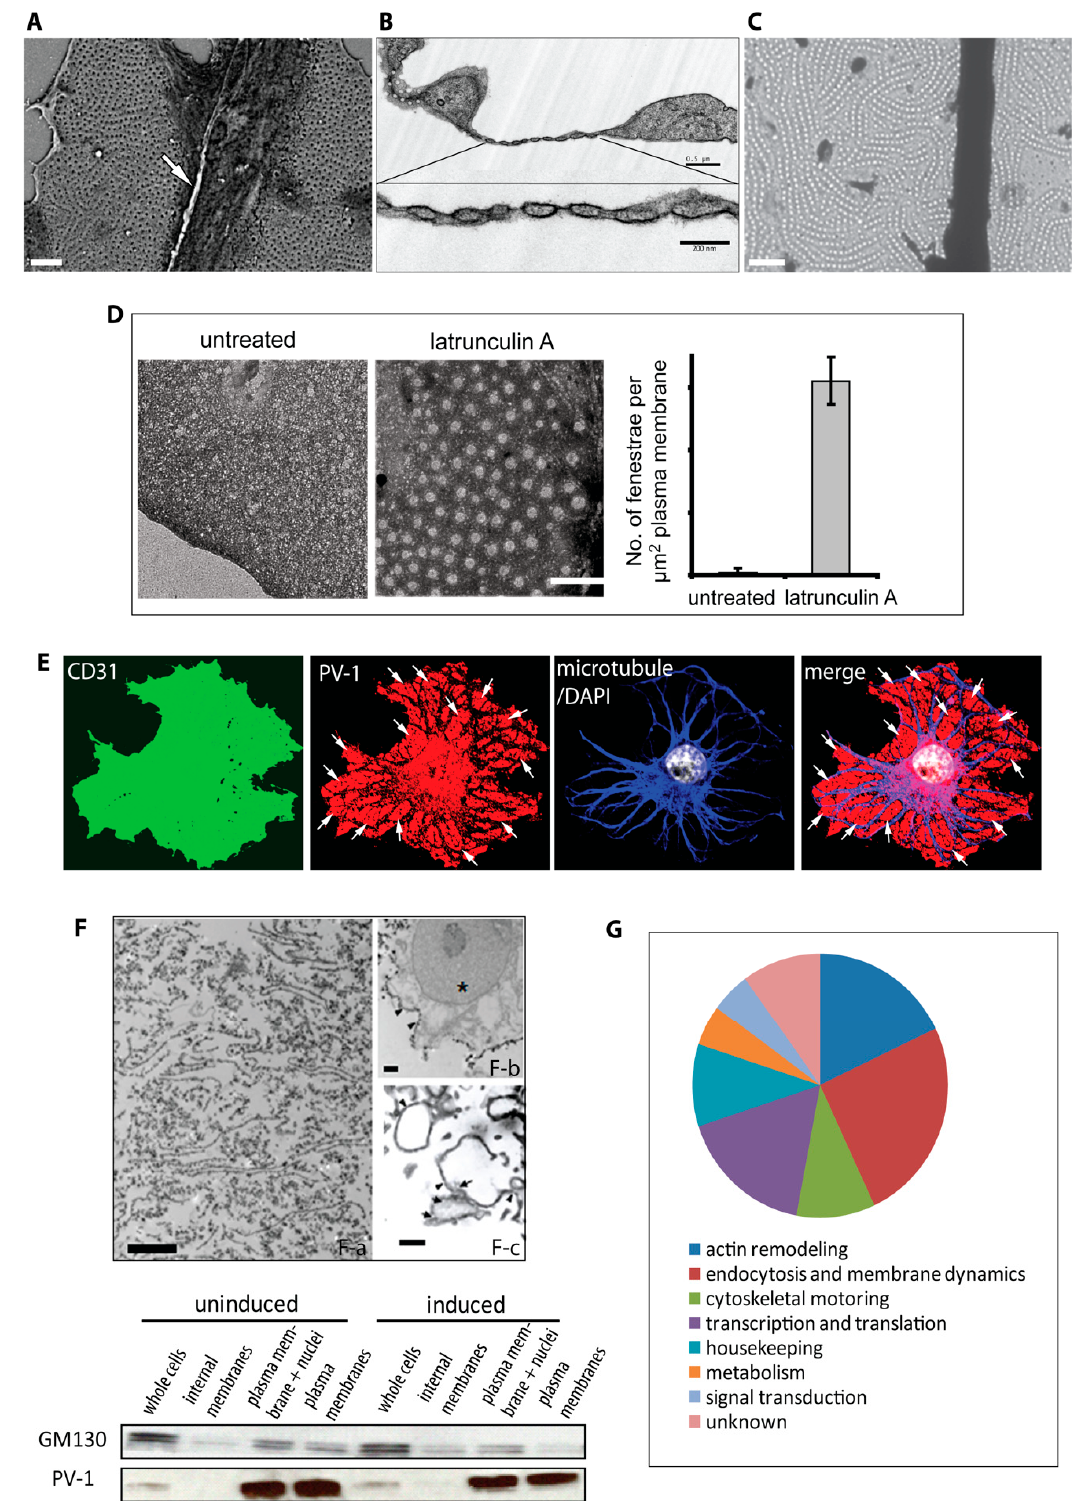
Figure 1. Fenestra morphological and proteomic characterisation. The pores are present in the highly attenuated cell periphery in clusters devoid of most organelles and cytoskeleton, termed sieve plates ( A ) SEM image (arrow, microtubule; scale bar, 1 µm). Fenestrae form in areas of the cell where the apical–basal plasma membrane distance is as little as 40 nm. The pore diameter is approximately 60 nm, and it is spanned by a pinwheel-like diaphragm. Substances that traverse the pore never encounter the contents of the cytoplasm. ( B ) Thin-section TEM image (arrows, fenestral diaphragm; top scale bar, 1 µm; bottom scale bar, 200 nm). In the sieve plates, fenestrae are highly organised in